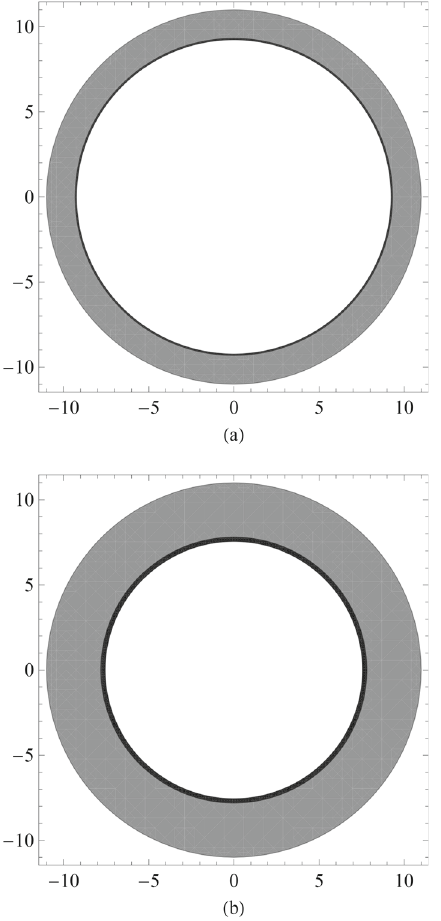
Fig. 21 Cross sectional view of the star PSR J1614-2230 for different stability region of quarks. Here inner region marked with white colour represents stable quark relative to 56 Fe above which a thin layer of metastable quark exists which is shown in black colour and the outer layer in gray colour consists of unstable quarks. Figure in the top panel ( a ) is plotted without charge ( γ = 0) and in the bottom panel ( b ) we consider the effect of charge and take γ = 0 . 2. The pressure anisotropy ( α ) is set to 0.1